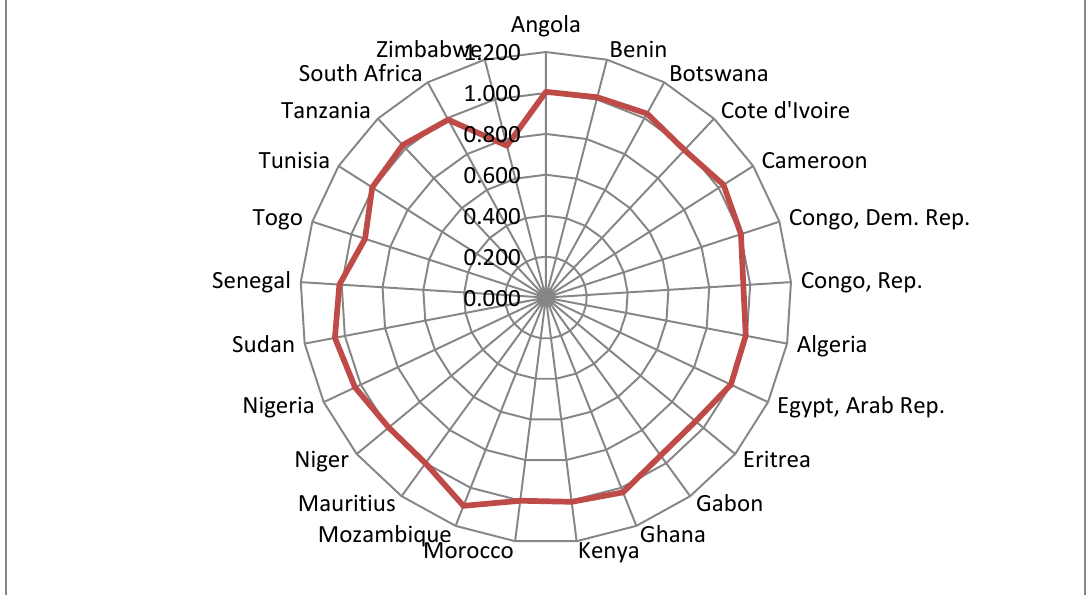
Figure 5. Mean Malmquist productivity index (MPI) scores with CO 2 emission for the 25 sample countries in 2006–2014.